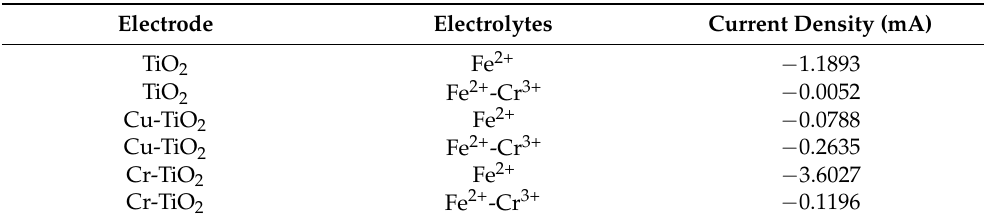
Figure 1. (a) The Mott-Schottky curve of metal ion-doped TiO 2 electrode in different electrolytes; (b) instantaneous current plot of metal ion-doped TiO 2 electrode in different electrolytes. Table 1. Instantaneous current plot of metal ion-doped TiO 2 electrode in different electrolytes (0–120 s).